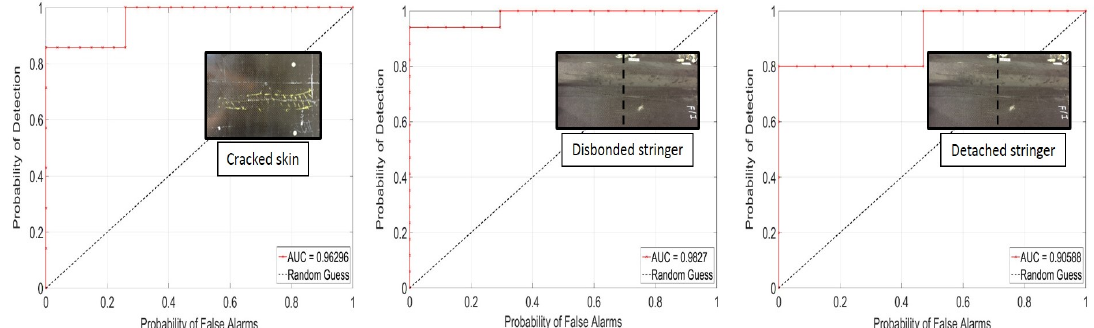
Figure 11. Receiver operating characteristic (ROC) curves for the contact non-destructive evaluation (NDE) technique: cracked skin, disbonded stringer, and detached stringer defects (Panel 1 and Panel 2).